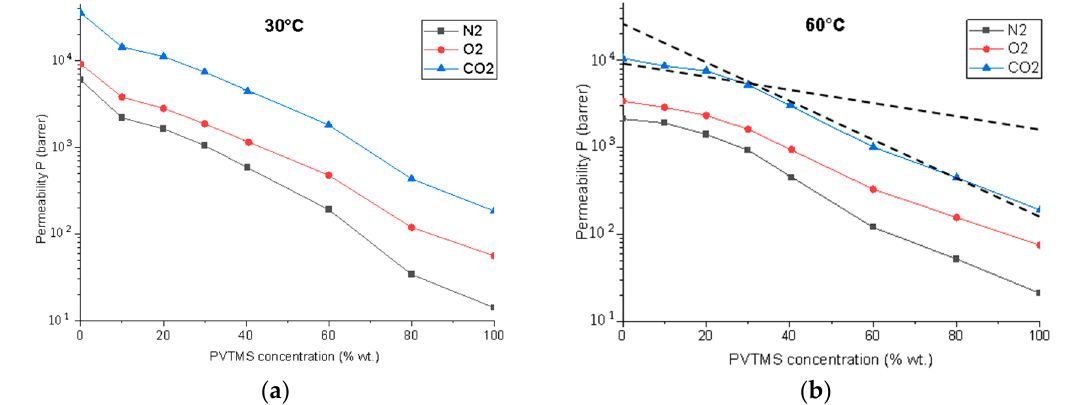
Figure 5. Gas permeability coefficients of membranes from PTMSP/PVTMS blends for gases O 2 , CO 2 , and N 2 at temperatures of ( a ) 30 and ( b ) 60 °C. Table 3. The gas permeability and selectivity data for highly permeable glassy polymer blends.